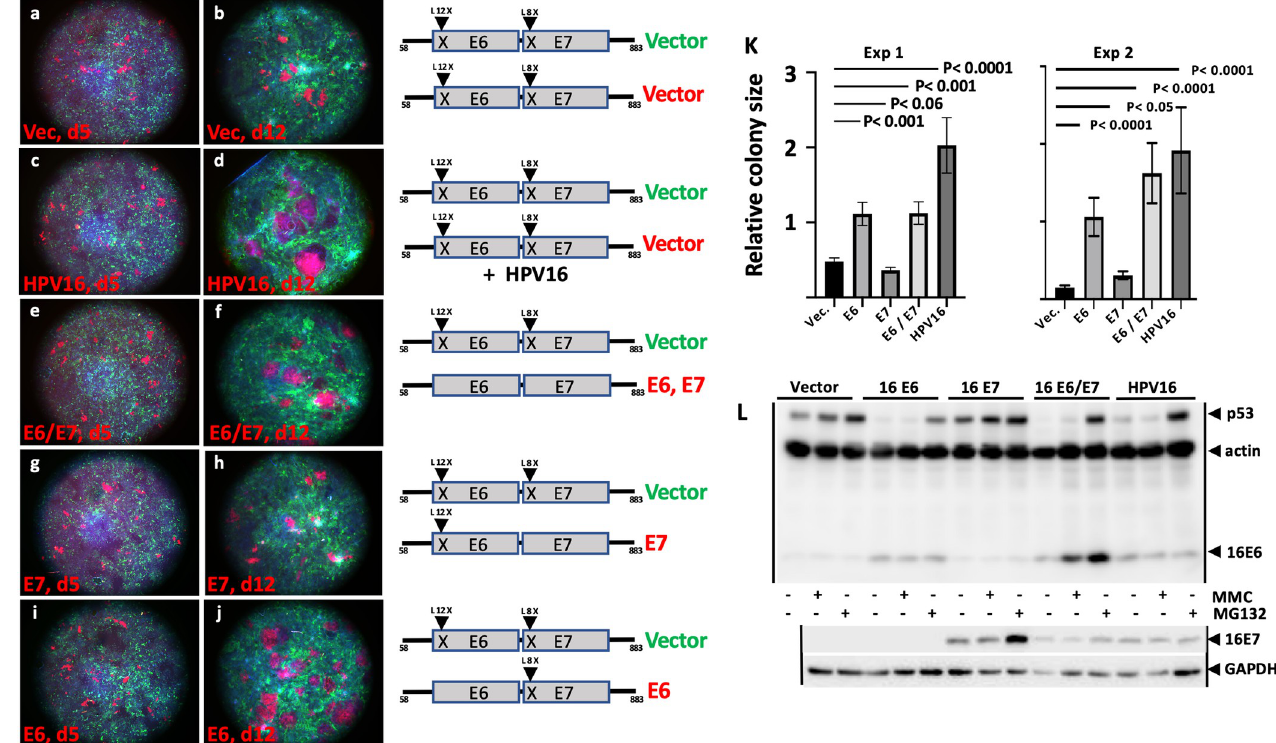
Fig 2. Enhanced cell colony competition is induced by HPV16 and by HPV16 E6. Vector-transduced green NIKS cells and oncogene-expressing red NIKS cells were seeded together as described in Fig 1 onto coverslips on day 2 and fixed at confluency on day 5 (Fig 2A, 2C, 2E, 2G, and 2I); a second coverslip was fixed on day 12 (Fig 2B, 2D, 2F, 2H, and 2J). The transduced, selected and stably expressed genes are indicated to the right of each pair. The quantified results of colony sizes (in arbitrary units) from 2 individual representative experiments (out of a total of 4 experiments) is shown (Fig 2K). Western blots for the stably transduced cell lines selected in Fusion Red expressing cells is shown (Fig 2L). MMC refers to treatment with mitomycin C that induces p53 expression, and MG132 refers to the presence of proteasome inhibitor MG132 which blocks the proteasomal degradation of p53. On Day 5 colony sizes were not statistically different between the samples and are not shown. HPV16 and E6 confer enhanced cell colony size at day 12 while E7 does not. Error bars in Fig 2K depict standard error of the mean for colony sizes.